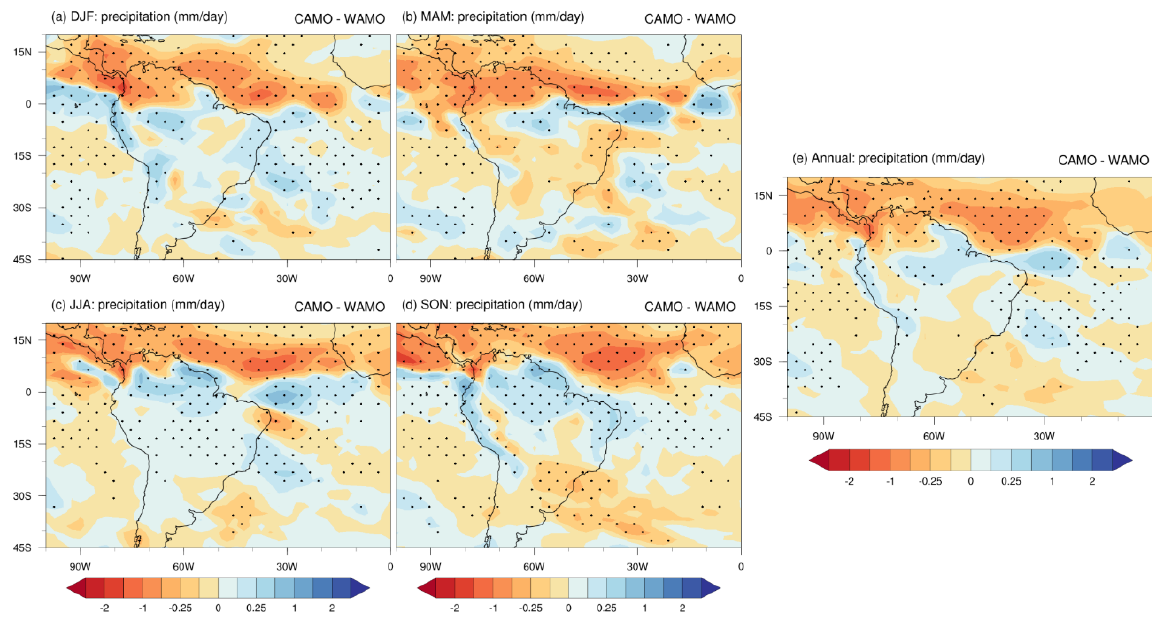
Figure 2. Seasonal precipitation differences between the cold Atlantic Multidecadal Oscillation (CAMO) and the warm Atlantic Multidecadal Oscillation (WAMO) experiments (mm/day) in ( a ) December – February (DJF), ( b ) March – May (MAM), ( c ) June – August (JJA), and ( d ) September – November (SON) and ( e ) annual mean. Red (blue) shaded areas correspond to drier (wetter) conditions; grid points with statistically significant difference according to Student’s t test with confidence level of 95% are marked with dots.